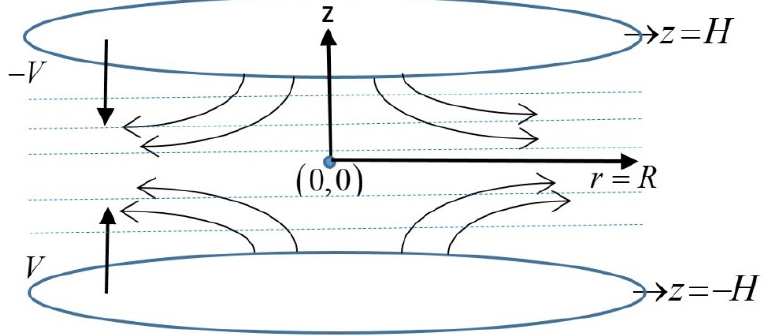
Figure 1. Geometry of the squeeze flow when both disks approach each other. The velocity vector ( V ) for axisymmetric flow is considered in Equation (1).